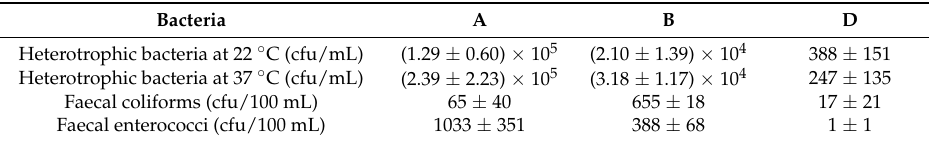
Table 3. Concentration of total heterothophic bacteria and faecal indicators (faecal coliforms and faecal enterococci) in wastewater effluent flowing through the ponds system, grown in agar mediums. A, B, and D are the sampling points.